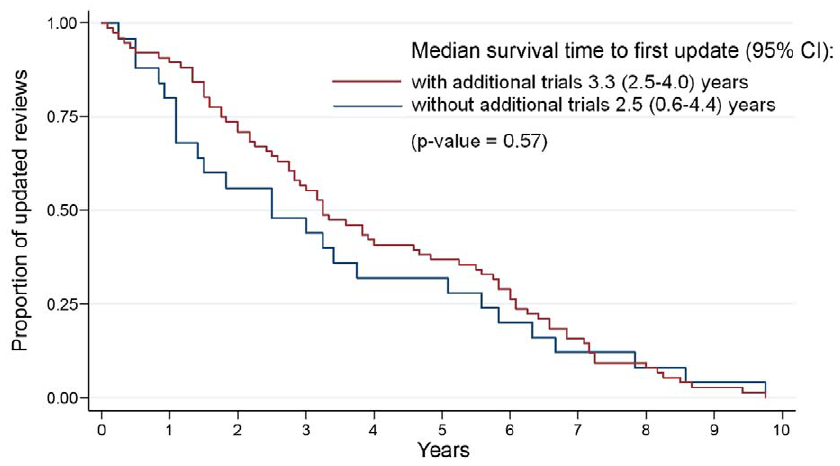
Figure 3. Kaplan–Meier curves for reviews with and without additional trials at first update.